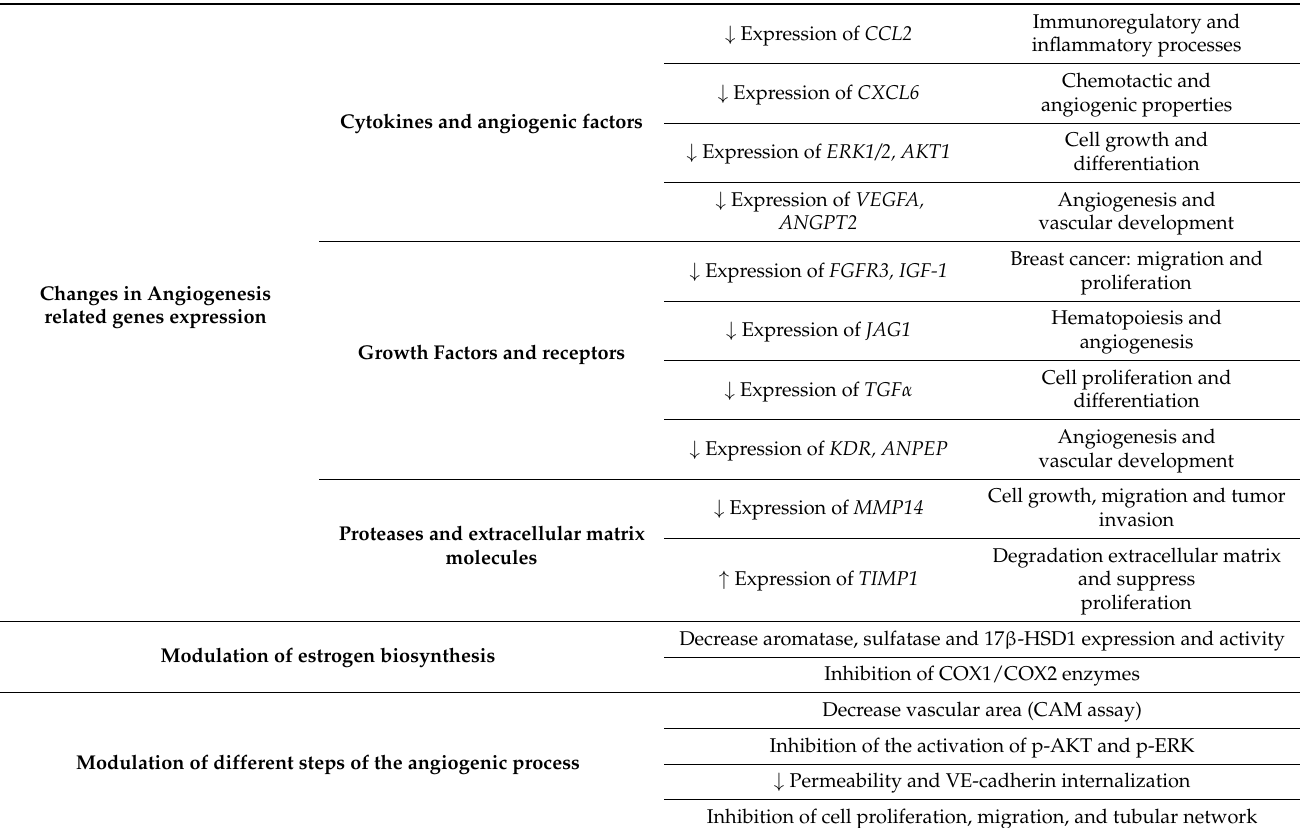
Changes in Angiogenesis related genes